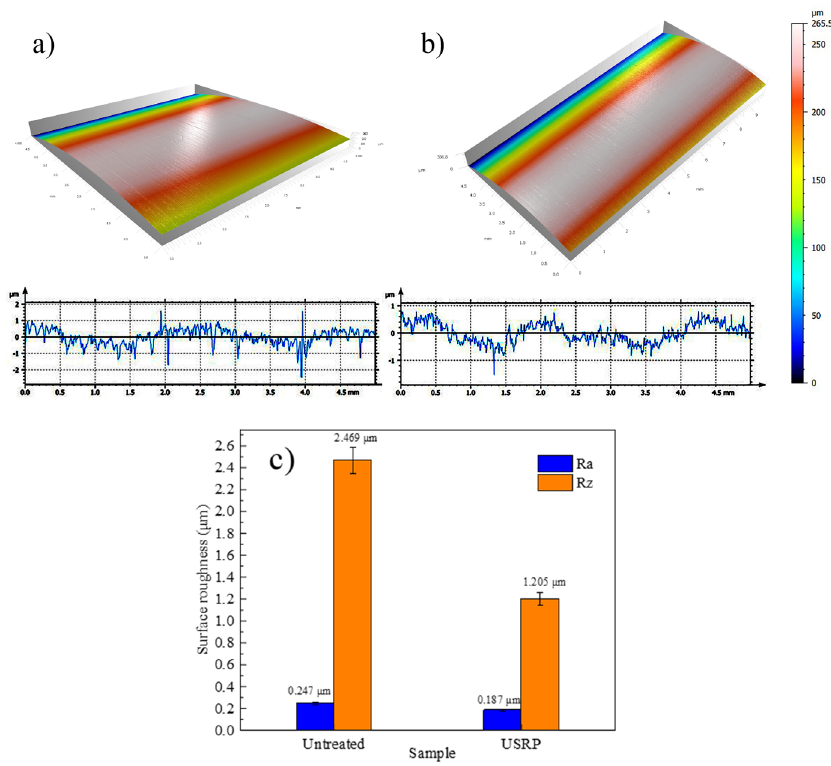
Figure 12. Three-dimensional morphology and surface roughness of sample surface before. and after USRP treatment: (a) untreated specimen; (b) USRP treated specimen; (c) comparison of Ra and Rz before and after USRP